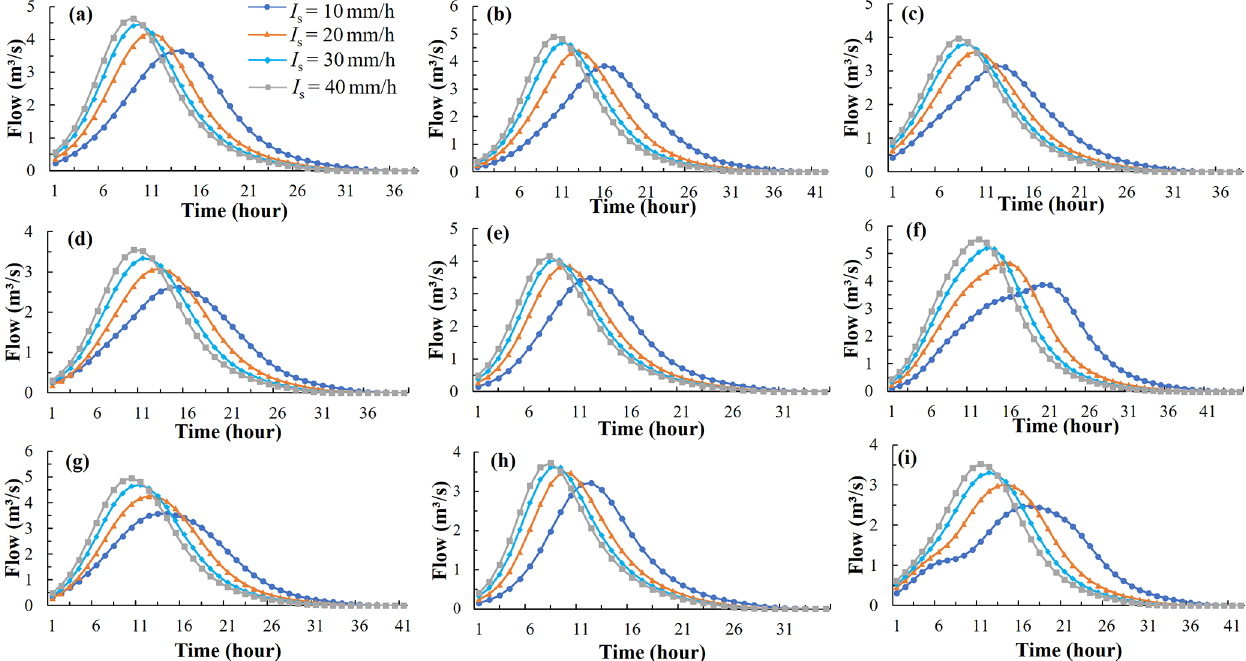
Figure 10. The TDUH for the Qin River basin. (a) Sub-basin 1. (b) Sub-basin 2. (c) Sub-basin 3. (d) Sub-basin 4. (e) Sub-basin 5. (f) Sub-